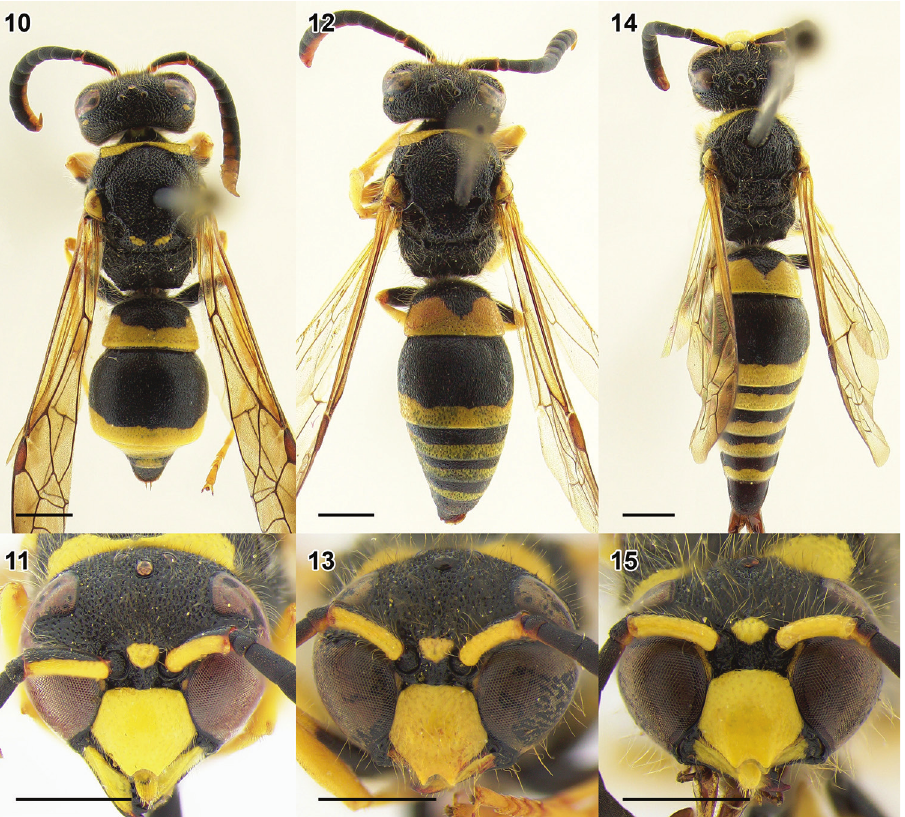
Figures 10–15. Ancistrocerus raddei (Kostylev, 1940), Russia (Altai) ( 10, 11 ), A. dusmetiolus (Strand, 1914), Spain ( 12, 13 ), and A. dusmetiolus , Uzbekistan (“ Odynerus alius Kostylev, 1935”) ( 14, 15 ), males 10, 12, 14 dorsal habitus 11, 13, 15 head in frontal view. Scale bars 1.0 mm.